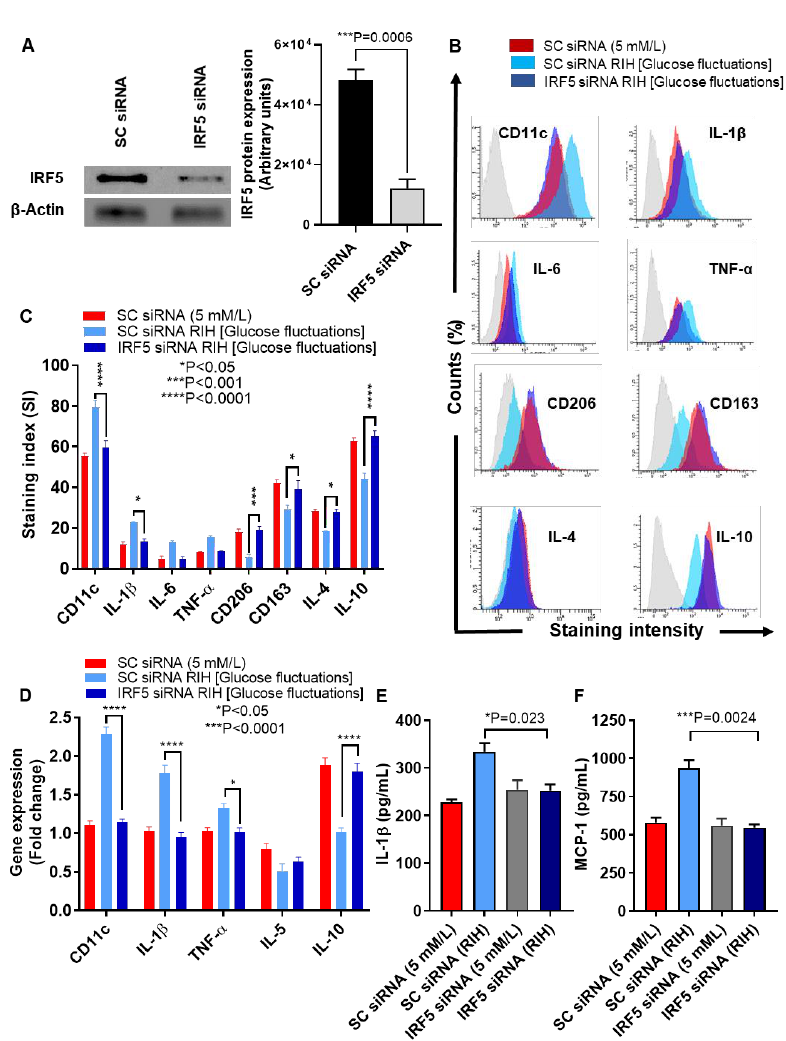
Figure 3. IRF5 silencing prevents the expression of M1 markers and inflammatory cytokines/chemokine in THP-1 macrophages cultured under repetitive intermittent hyperglycemia (RIH). THP-1 monocytes were transfected with scrambled siRNA (mock/negative control) or IRF5